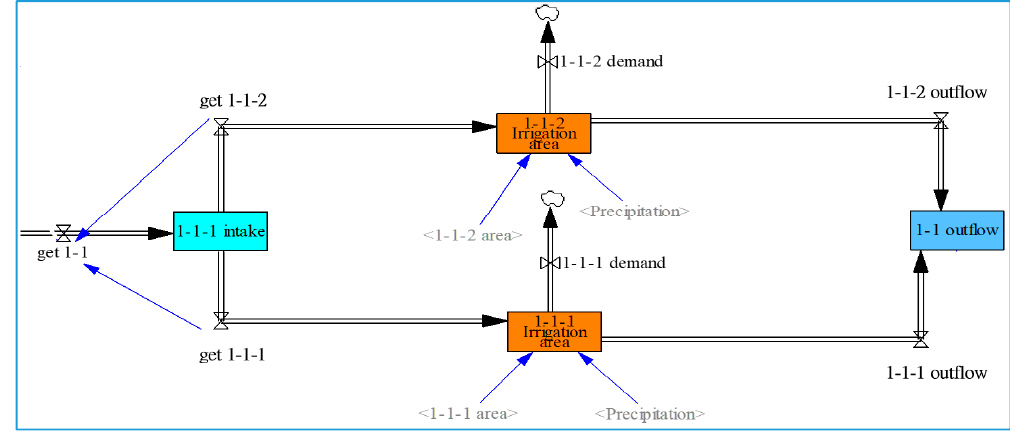
Figure 8. Direction and sequence of the drainage and irrigation in the study region.